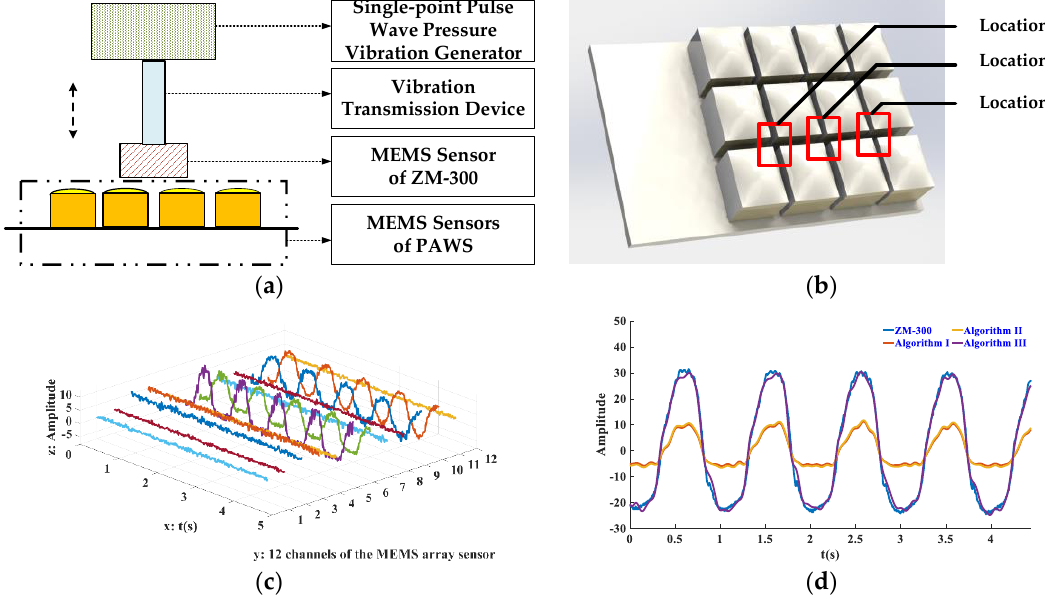
Figure 5. ( a ) Diagram of SPVG and ZM-300 mutual extrusion; ( b ) diagram of the test area at three different locations on the PAWS sensor array; ( c ) pulse waveform graphs collected by twelve sensors in the PAWS sensor array; ( d ) at location 1, waveforms of the standard input signal and the signal processed by the three algorithms.